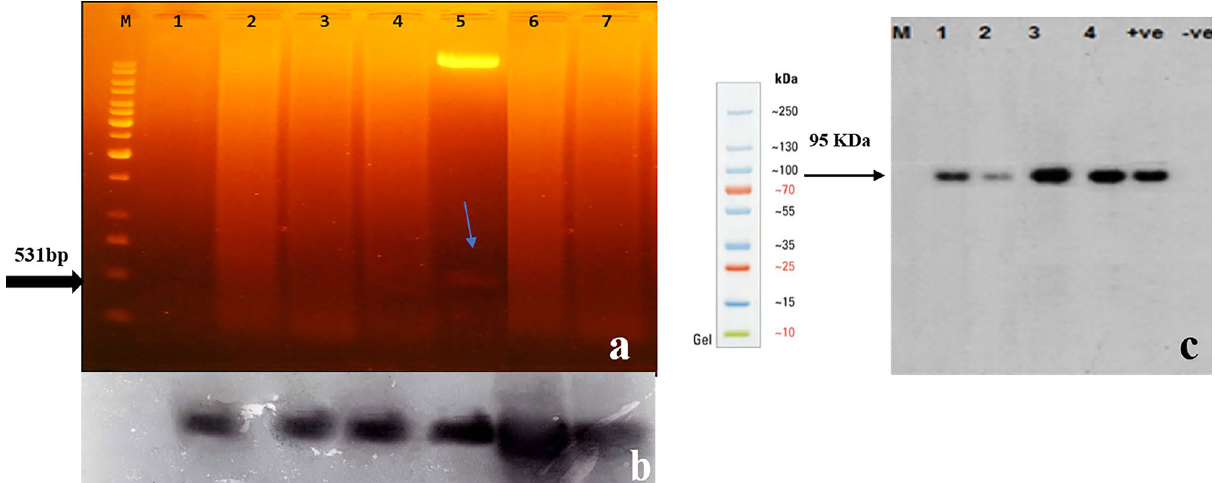
Figure 5. Confirmation of transgene ( GaZnF ) through southern and Western blot analysis. ( a,b ) Lane M. 1 kb DNA Ladder, Lane 1. Negative Control (DNA of untransformed plant), Lane 5 is positive control (plasmid DNA of pCAMBIA-1301 with GaZnF gene), Lane 2, 3, 4 & 6, 7 (PF0027, PF0035, PF0039, PF0048 and PF0054 respectively). Selected Transgenic Cotton Plant Samples ( GaZnF ) were digested with Nco I and Bgl II probed with biotin-labeled GaZnF DNA to assess copy number of the transgene in the transformed plants. The presence of bands at size of positive control confirms the transgene’s integration in transgenic plants as compare to un-transformed plants that is used as negative control. Lane M contains 1 Kb ladder, lane 1 represent negative controls, lane 2, 4 and 6, 7 indicate the integration of GaZnF gene in selected transgenic cotton plant samples,